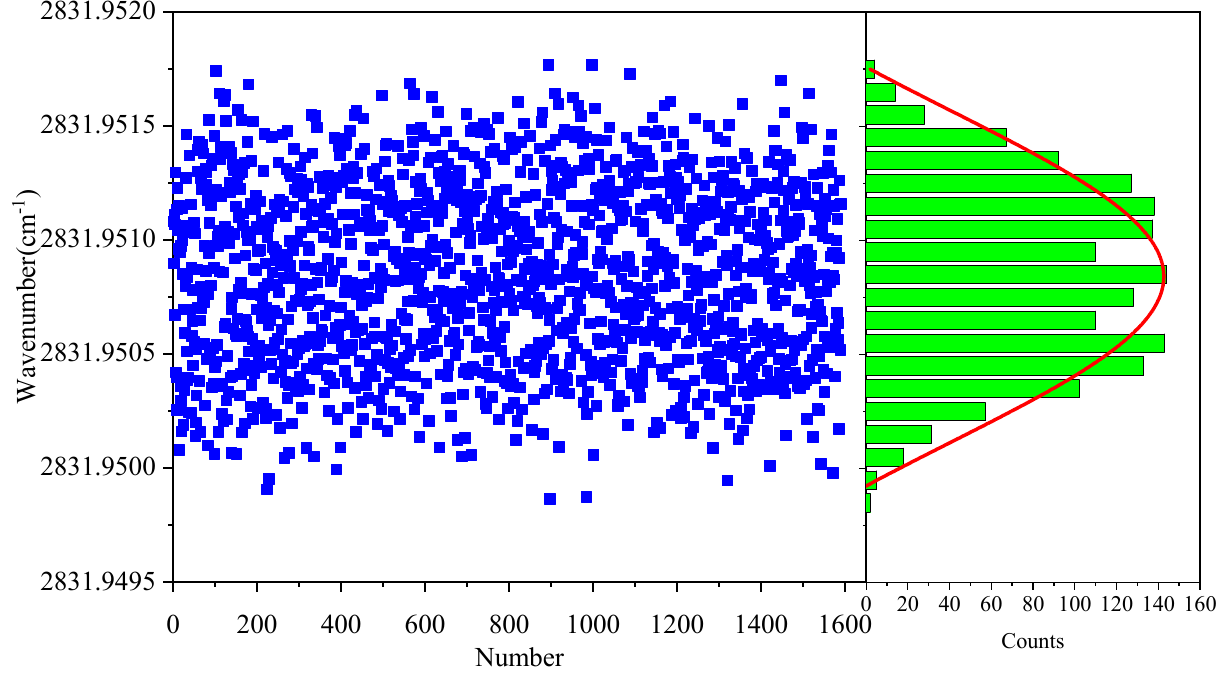
Figure 4. The wavelength stability of local oscillator.